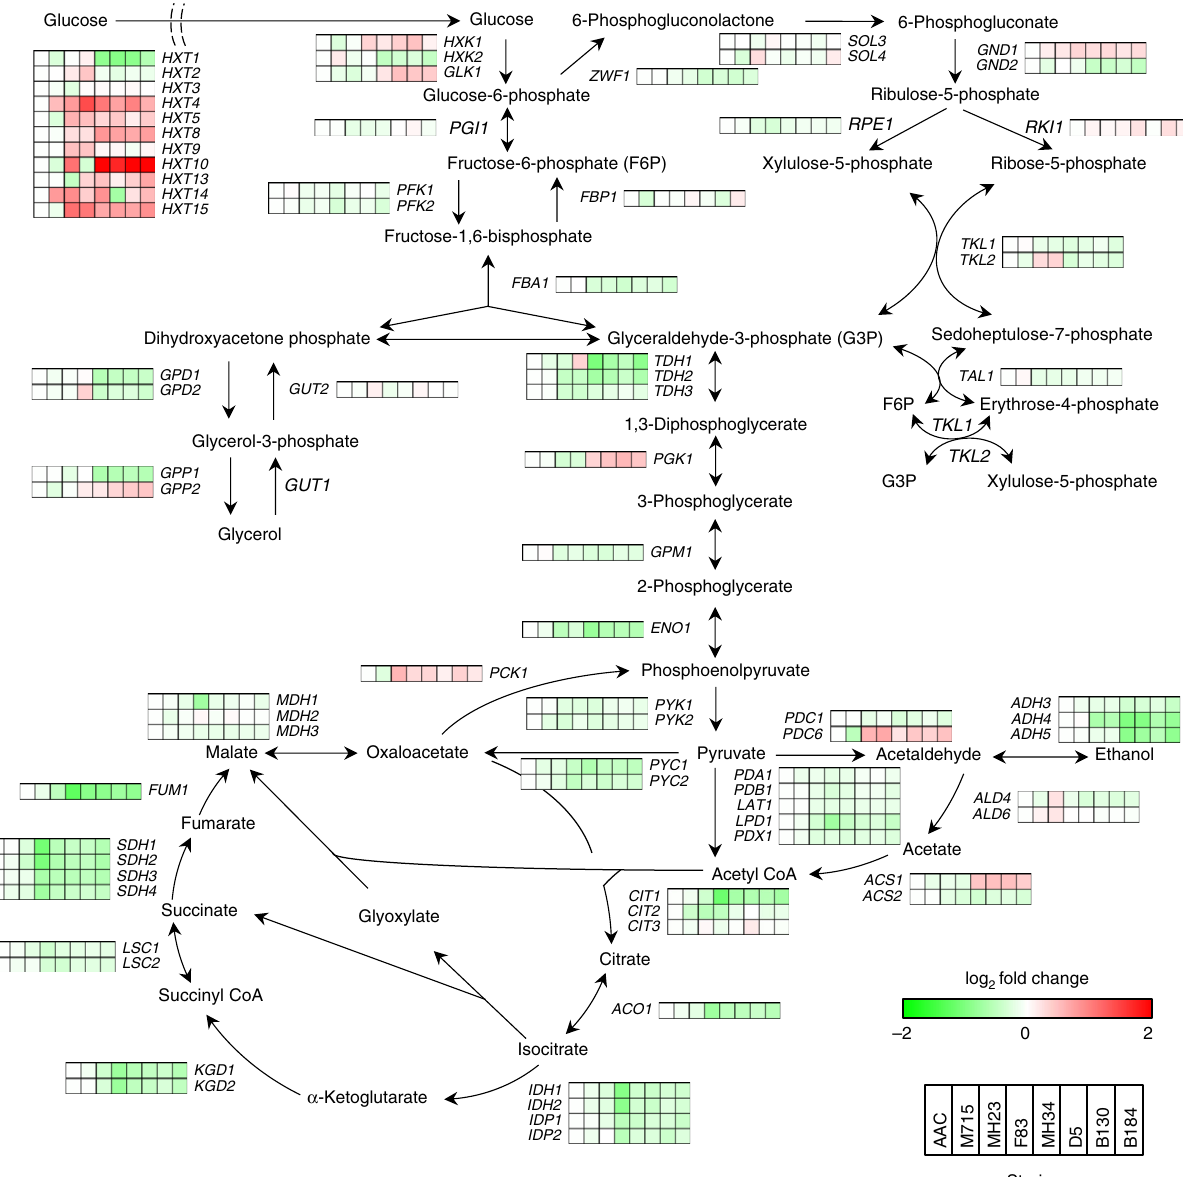
Fig. 4 Transcriptional changes of genes involved in carbohydrate metabolism. Most genes of the central carbon metabolism were downregulated and genes encoding high-af fi nity hexose transporters were upregulated in the mutant